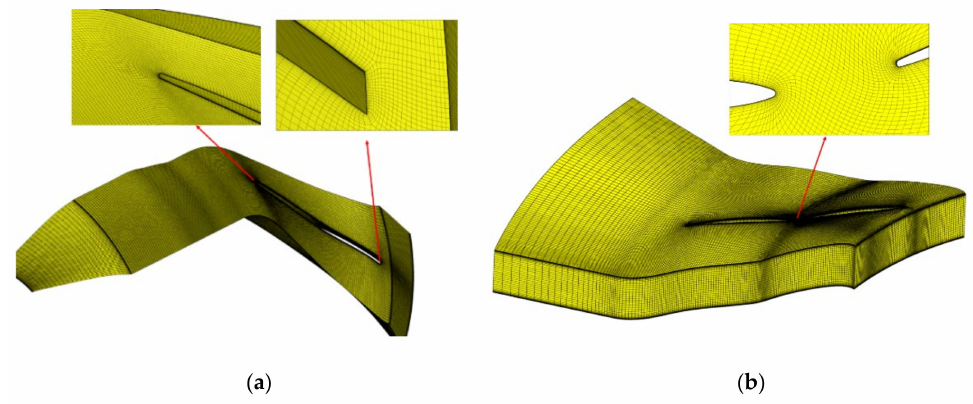
Figure 4. Meshes of computational domains. ( a ) Impeller and ( b ) Tandem vaned